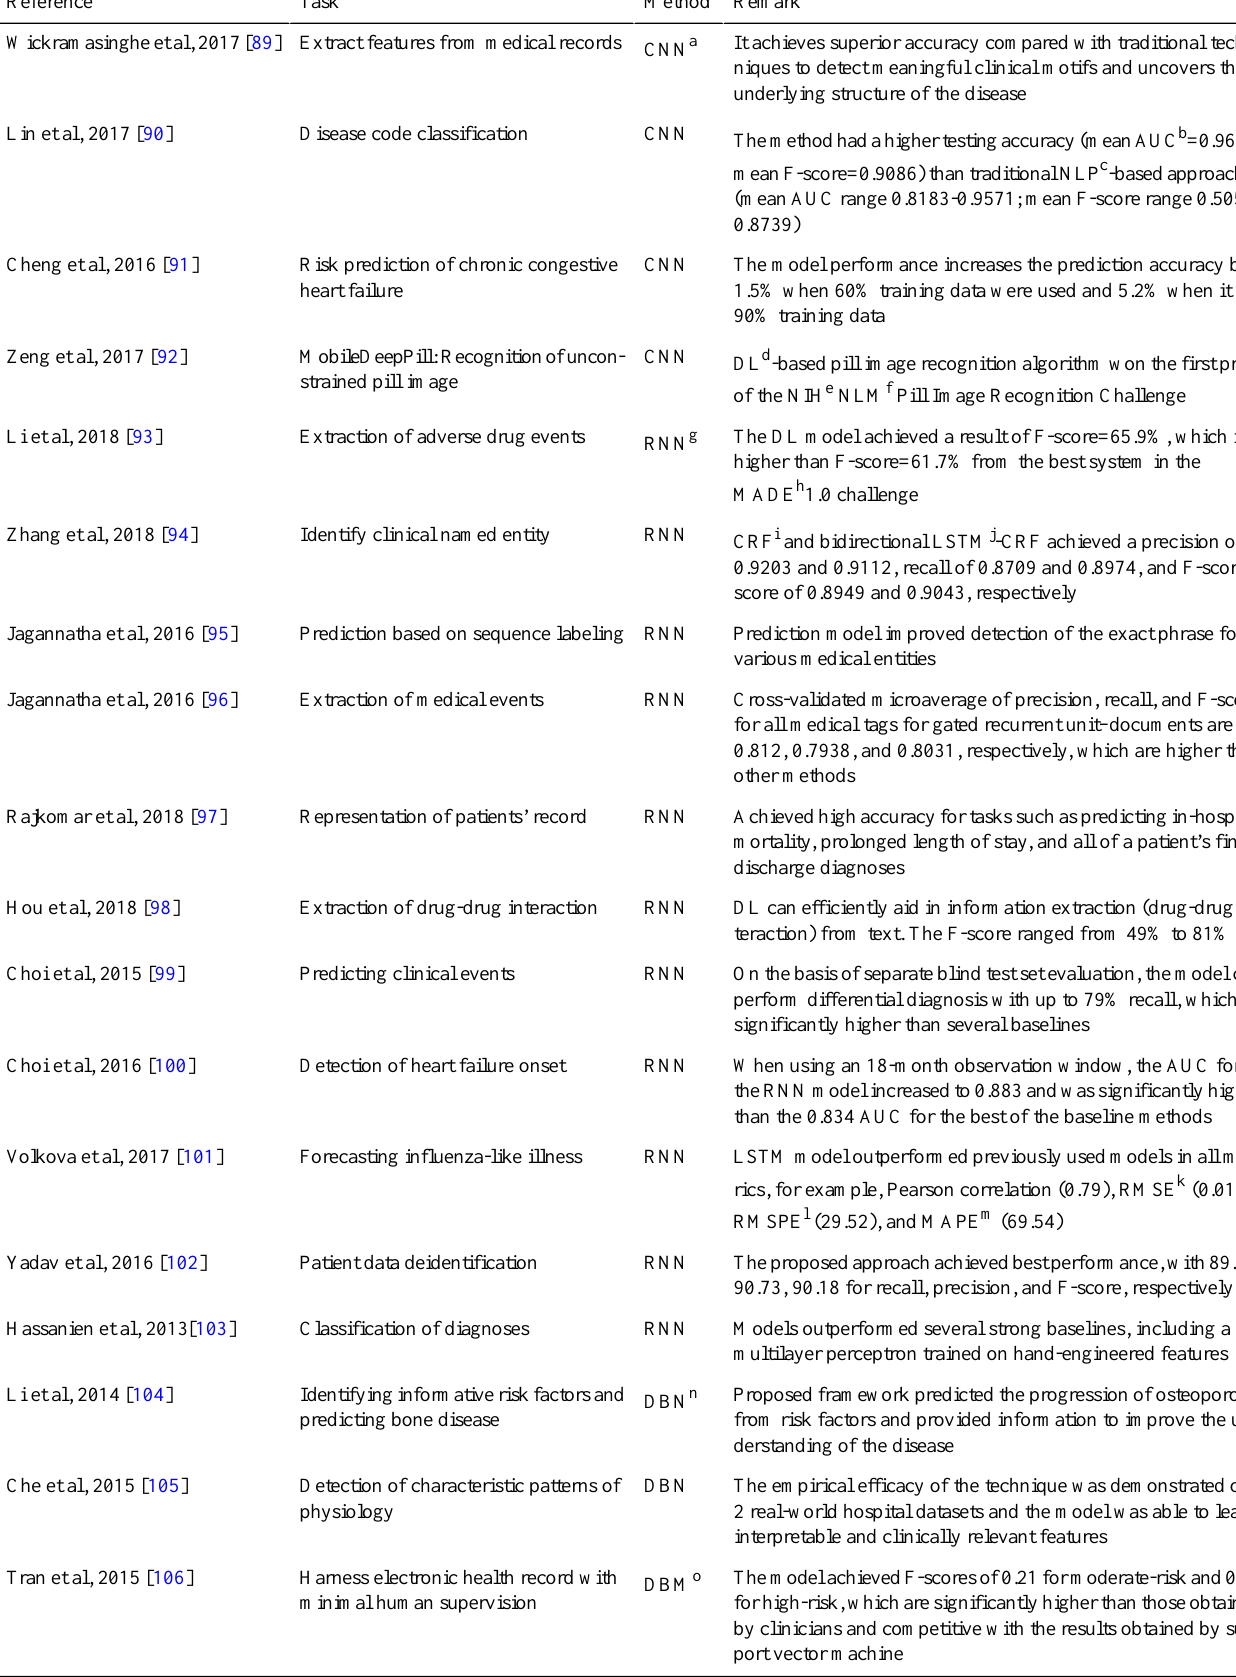
Table 2. Deep learning implementation in electronic health records and medical report